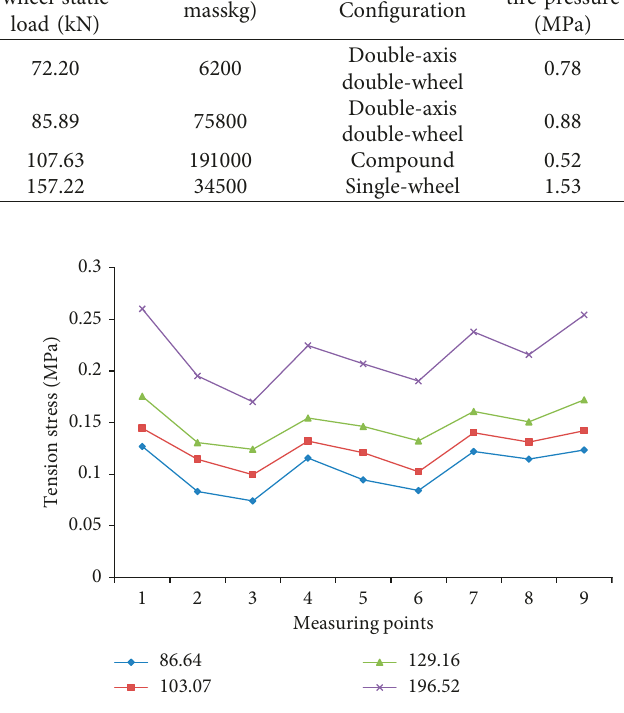
Figure 6: Tension stress value of each measuring point of the covered